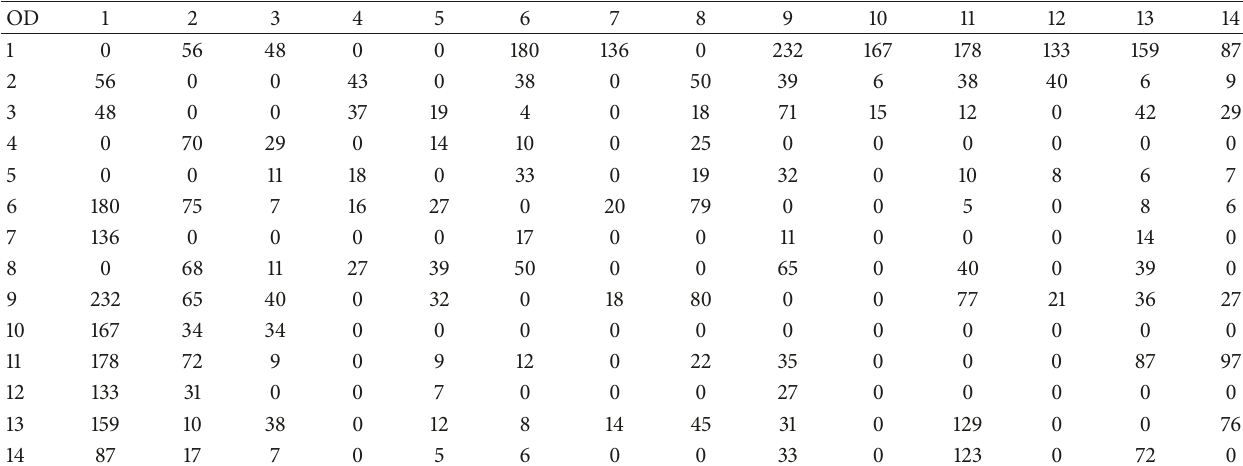
Table 3: Average daily demand 𝑄 𝑚 for each OD pair 𝑚 (items).